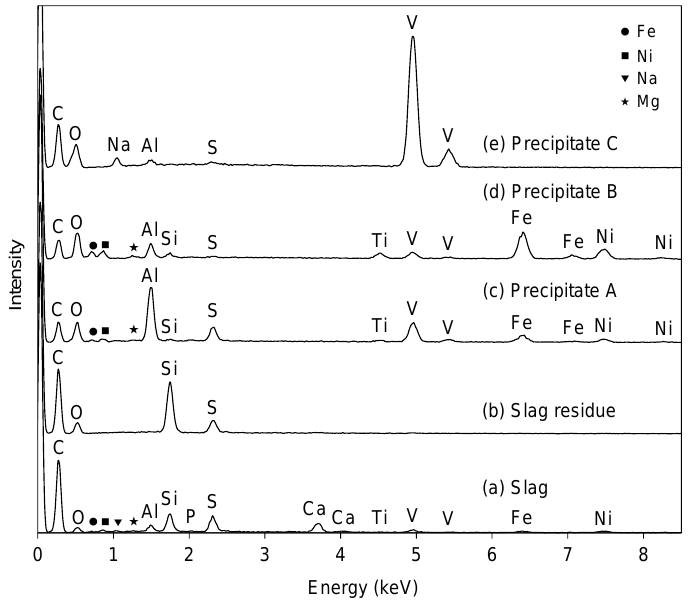
and the VO 2+ (aq) concentration in the solution.